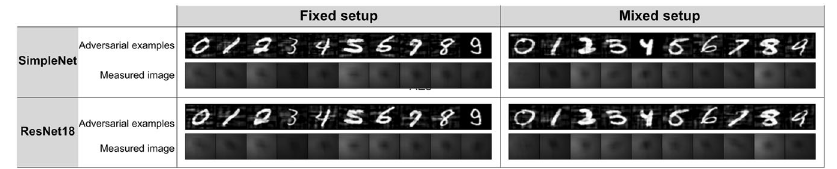
Fig. 5 Real-world attacks with increased L 2 on fi xed and mixed classi fi ers. Adversarial examples are generated on the monitor screen.